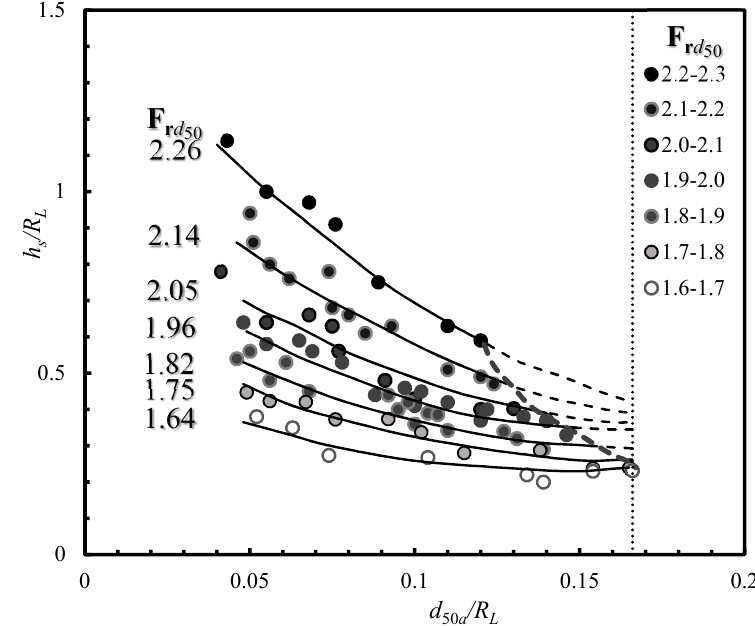
/ R L and F r d 50